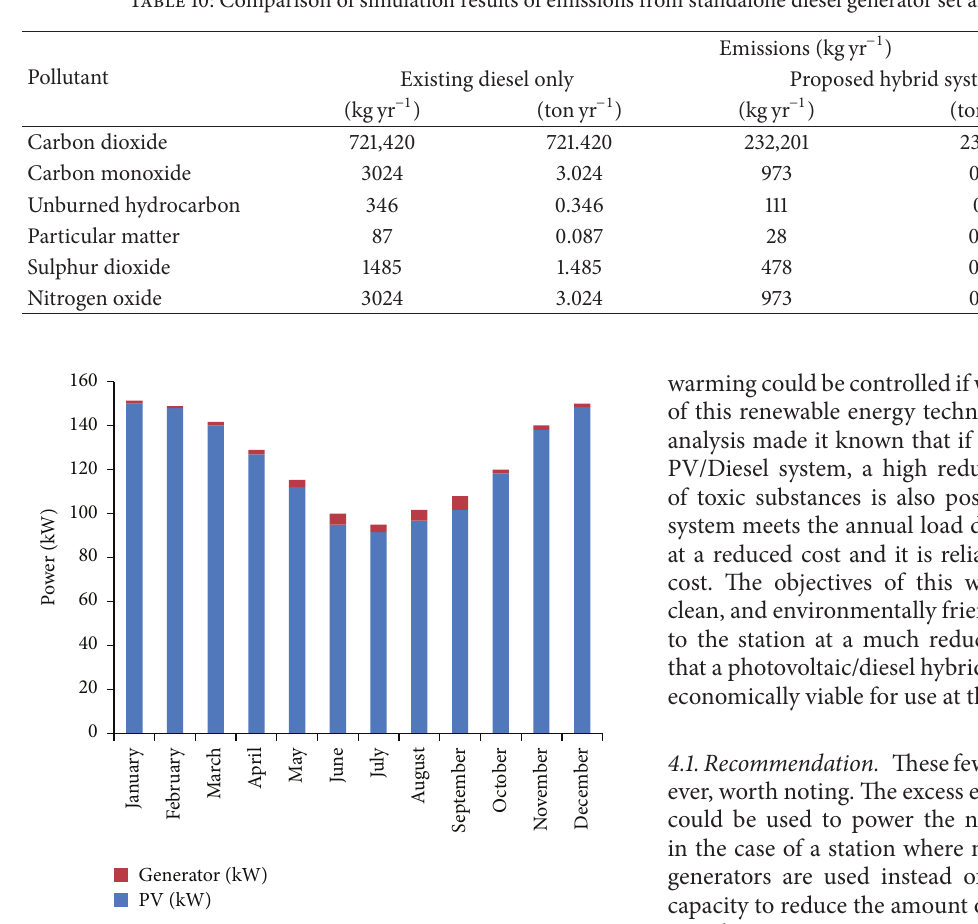
Figure 9: Monthly average of electrical power production of hybrid energy system